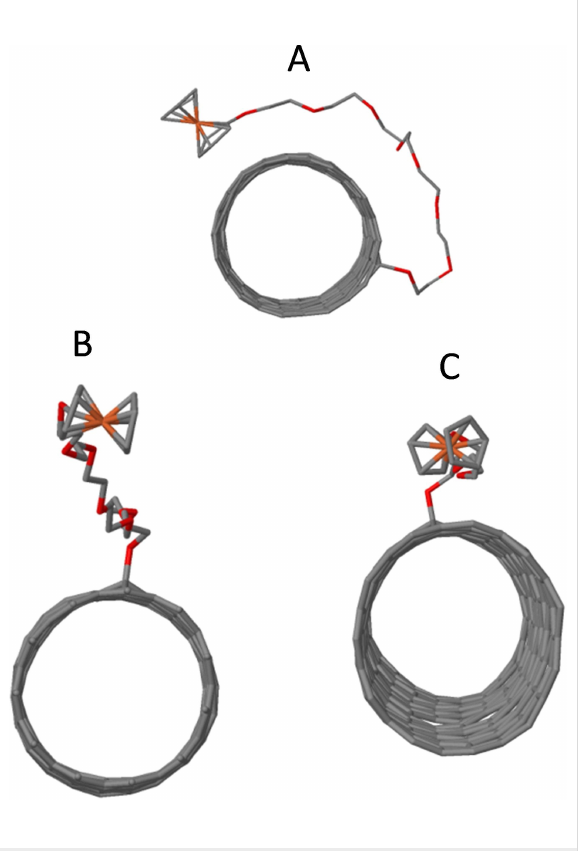
Figure 12: Molecular-dynamics simulated structures after 6 ns: A) HIPCO-FcETG 8 without the presence of water, B) HIPCO-FcETG 8 and C) HIPCO-FcETG 2 in the presence of water (not shown for